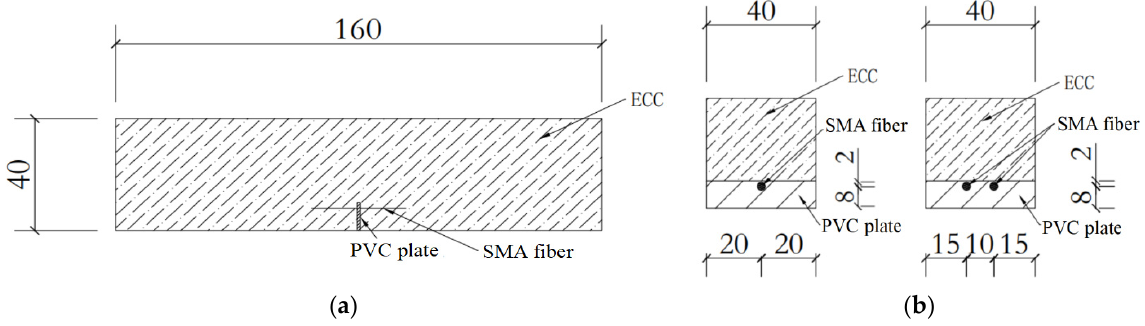
Figure 5. Details of the pre-notch beam specimen/mm: ( a ) Front view of the beam; ( b ) Mid-span section of the beam with sigle and double SMA